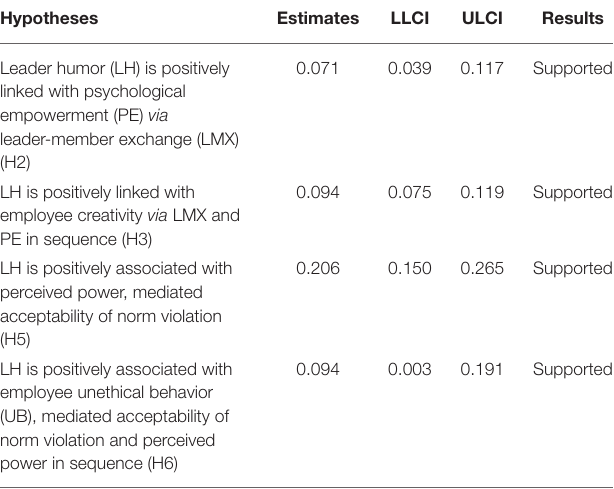
TABLE 4 | Summarized results of mediation and sequential mediation hypotheses.